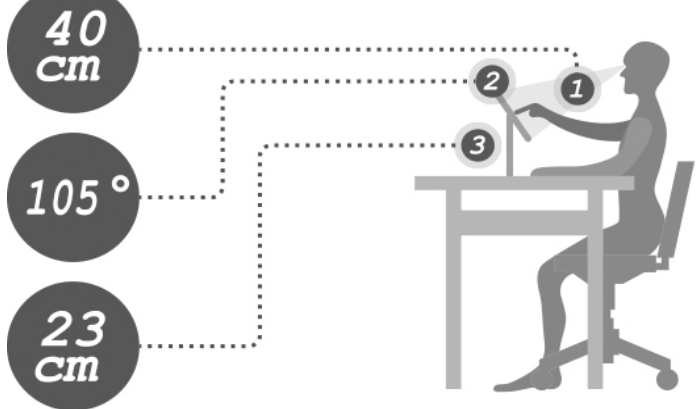
Figure 2. The layout of the experimental setting.